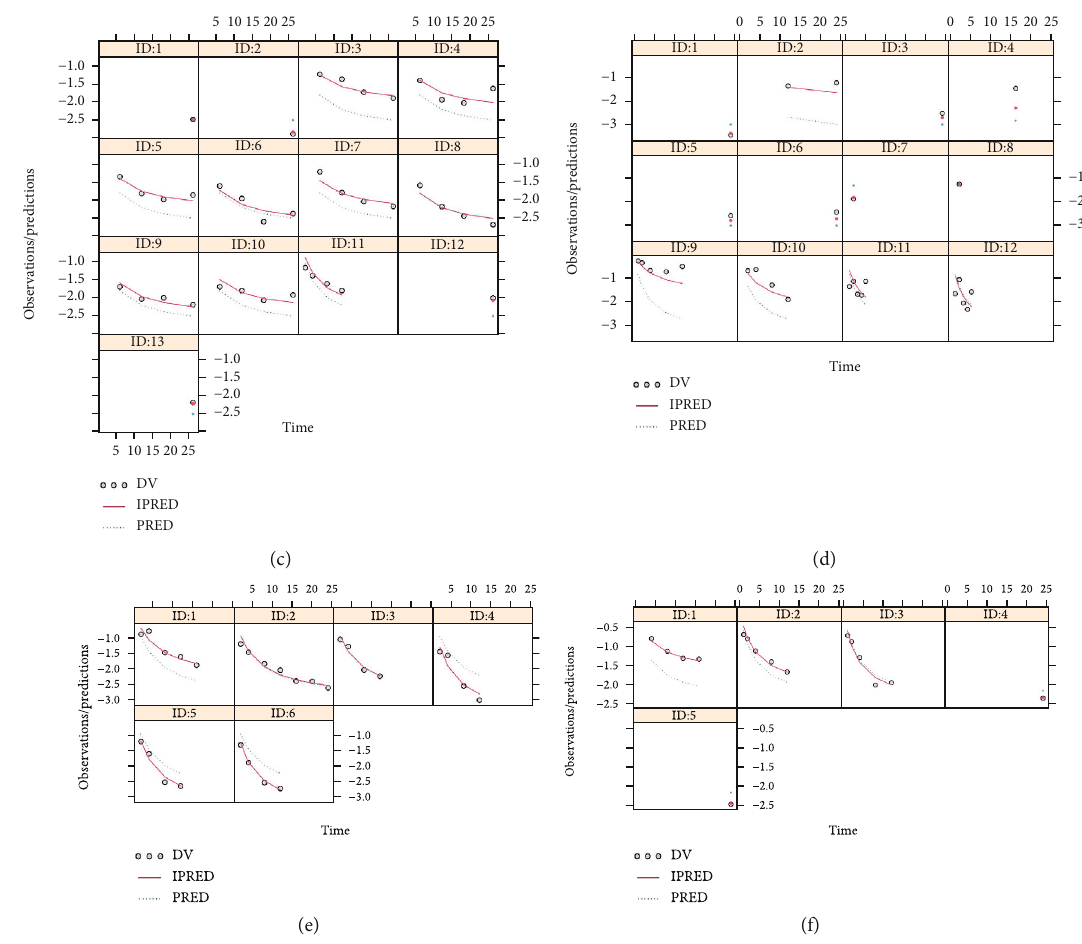
Figure 2: Individual plots: (a) canagli fl ozin, (b) empagli fl ozin, (c) ertugli fl ozin, (d) ipragli fl ozin, (e) luseogli fl ozin, and (f) tofogli fl ozin. Di ff erent IDs come from di ff erent groups of RCTs [12, 14 –